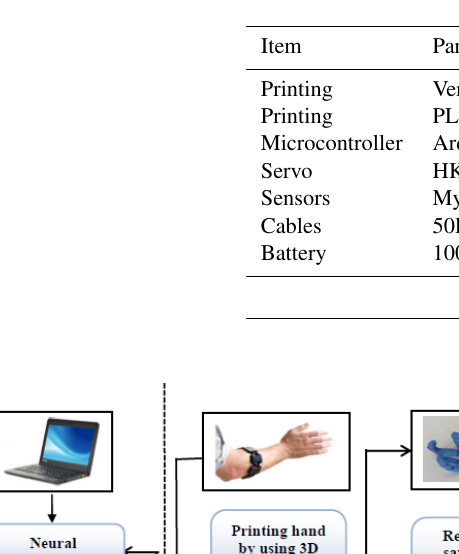
Figure 11. System diagram. Table 1. Cost breakdown of all the materials used in the 3D-printed robotic hand.